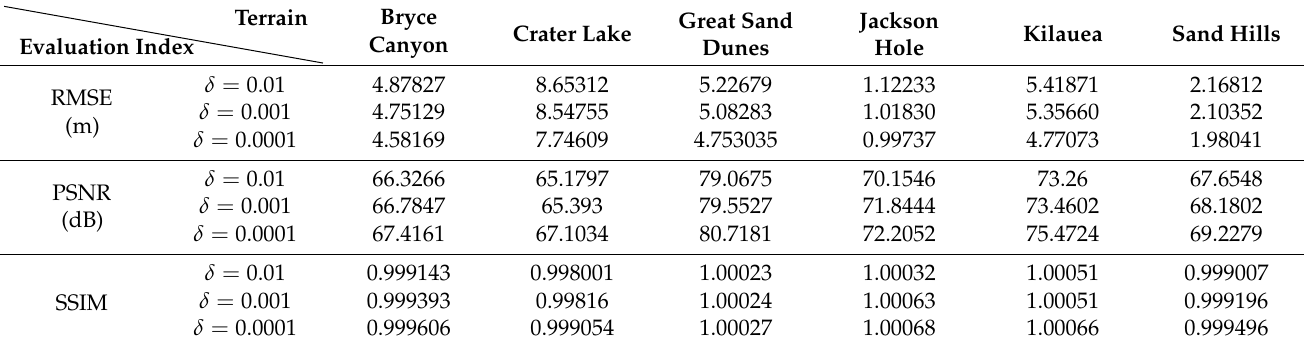
Table 3. Evaluation index of SR-DEM with different δ using No. 2 training datasets ( m = 500 ).